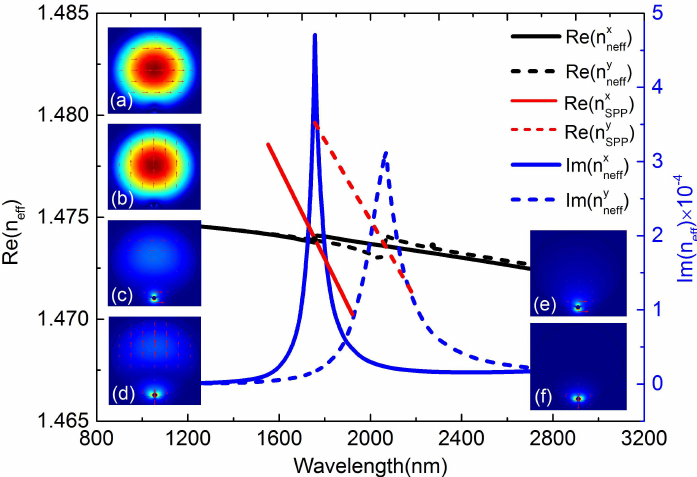
Figure 2. (Left) Dispersion relations of the core guided modes and the plasmon modes at temperature T = 22 ◦ C. (Insets) Electric field distributions of ( a ) core guided mode of x-pol at λ = 1.4 µ m; ( b ) core guided mode of y-pol at λ = 1.4 µ m; ( c ) core guided mode of x-pol at λ = 1.757 µ m (resonance wavelength); ( d ) core guided mode of y-pol at λ = 2.068 µ m (resonance wavelength); ( e ) plasmon mode of x-pol at λ = 1.75 µ m; ( f ) plasmon mode of y-pol at λ = 2.06 µ